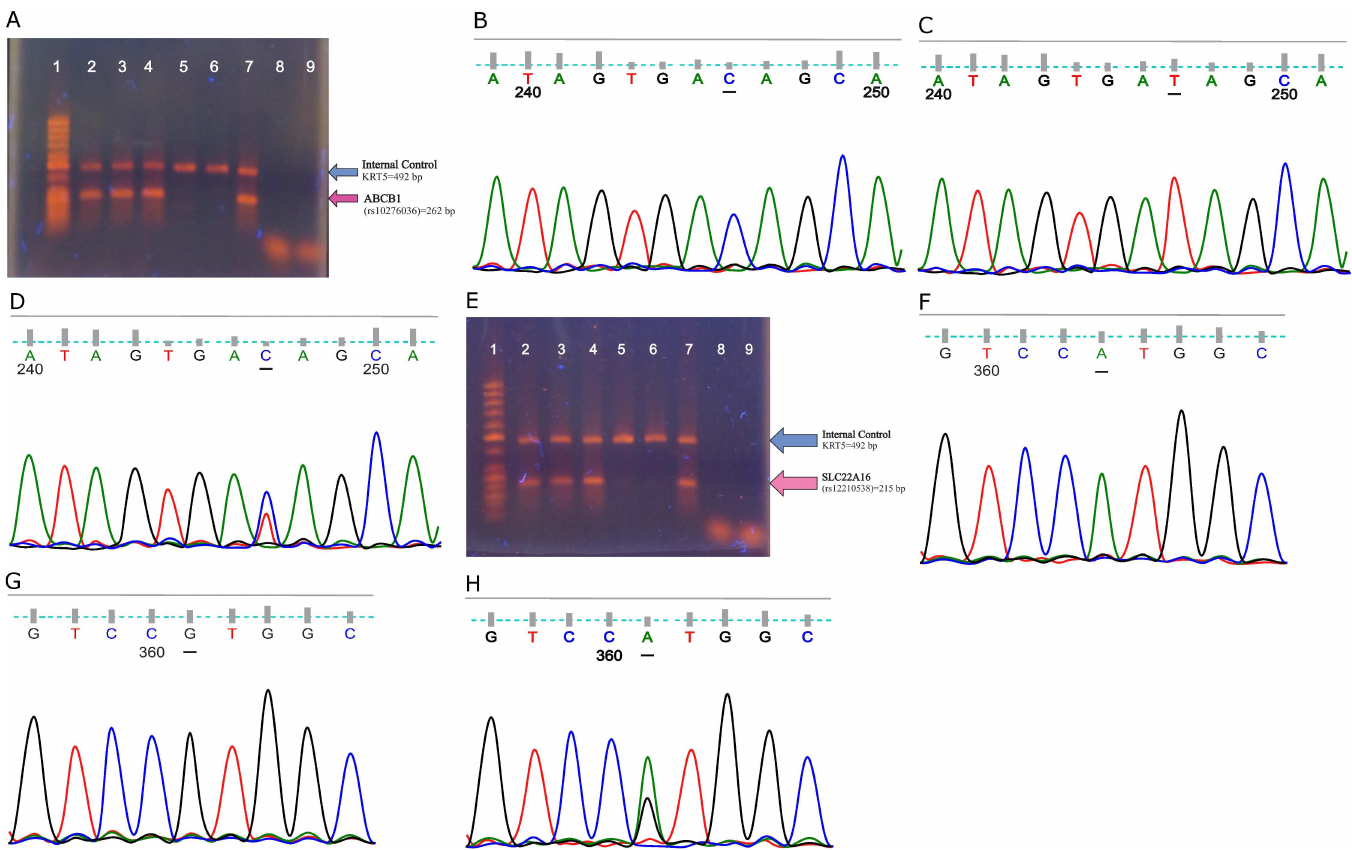
Fig 2. Fig 2A. Agarose gel image of the amplification refractorymutation system - PCR products of the ABCB1 gene polymorphism (rs10276036C/ T) . 1: 50 bp DNA ladder, 2 & 3: heterozygote allele C/T , 4 & 5: homozygote allele C , 6 & 7: homozygote allele T , 8 & 9: negativecontrol for alleles C and T respectively, Fig 2B. Electropherogram of the ABCB1 gene polymorphism (rs10276036C/T) homozygote allele C , Fig 2C. Electropherogram of the ABCB1 gene polymorphism (rs10276036C/T) homozygote allele T , Fig 2D. Electropherogram of the ABCB1 gene polymorphism (rs10276036 C/T) heterozygote allele C/T , Fig 2E. Agarose gel image of the amplification refractory mutation system-PCR products of the SLC22A16 gene polymorphism (rs12210538A/G) . 1: 50 bp DNA ladder, 2 & 3: heterozygote allele A/G , 4 & 5: homozygote allele A , 6 & 7: homozygoteallele G , 8 & 9: negativecontrol for alleles A and G respectively, Fig 2F. Electropherogram of the SLC22A16 gene polymorphism (rs12210538 A/G) homozygote allele A , Fig 2G. Electropherogram of the SLC22A16 gene polymorphism (rs12210538 A/G) homozygote allele G , Fig 2H. Electropherogram of the SLC22A16 gene polymorphism (rs12210538A/G) heterozygote allele A/G